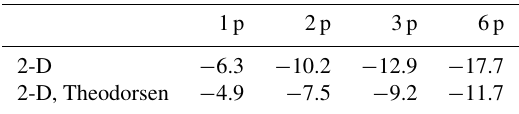
Table 5. c l phase shift, 75% blade cut, 2-D